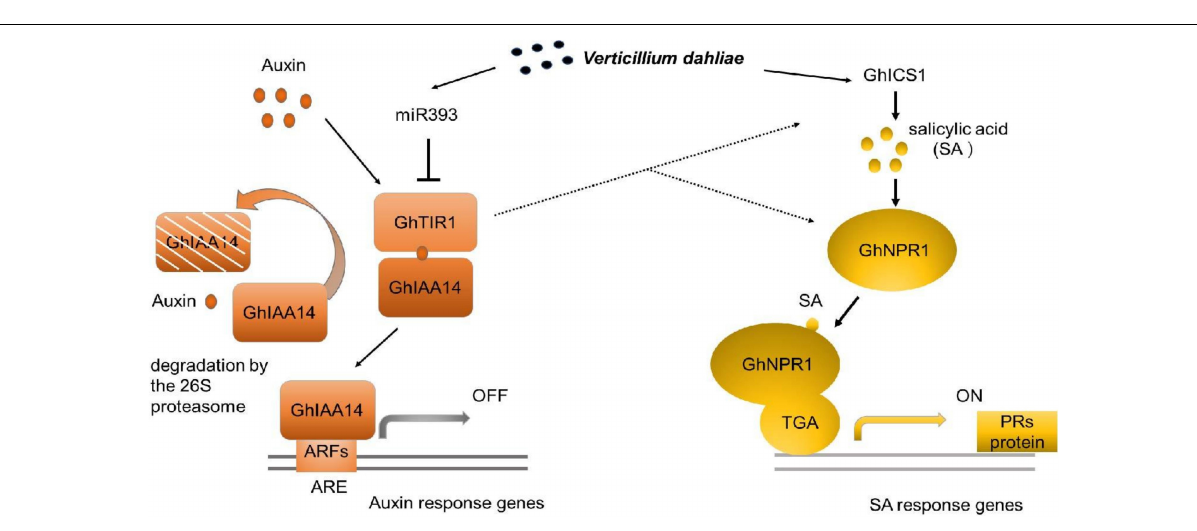
FIGURE 12 | Work model of the ghr-miR393-GhTIR1 module in plant response to Verticillium dahliae infection. Dashed lines indicated that ghr-miR393 overexpression and GhTIR1 knockdown activated ICS1 and NPR1 expression under V. dahliae infection. Auxin response element